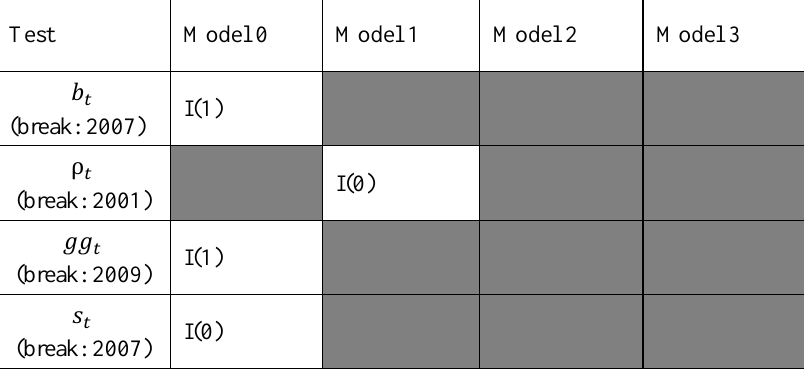
Table 4. Conclusions of the unit root tests with